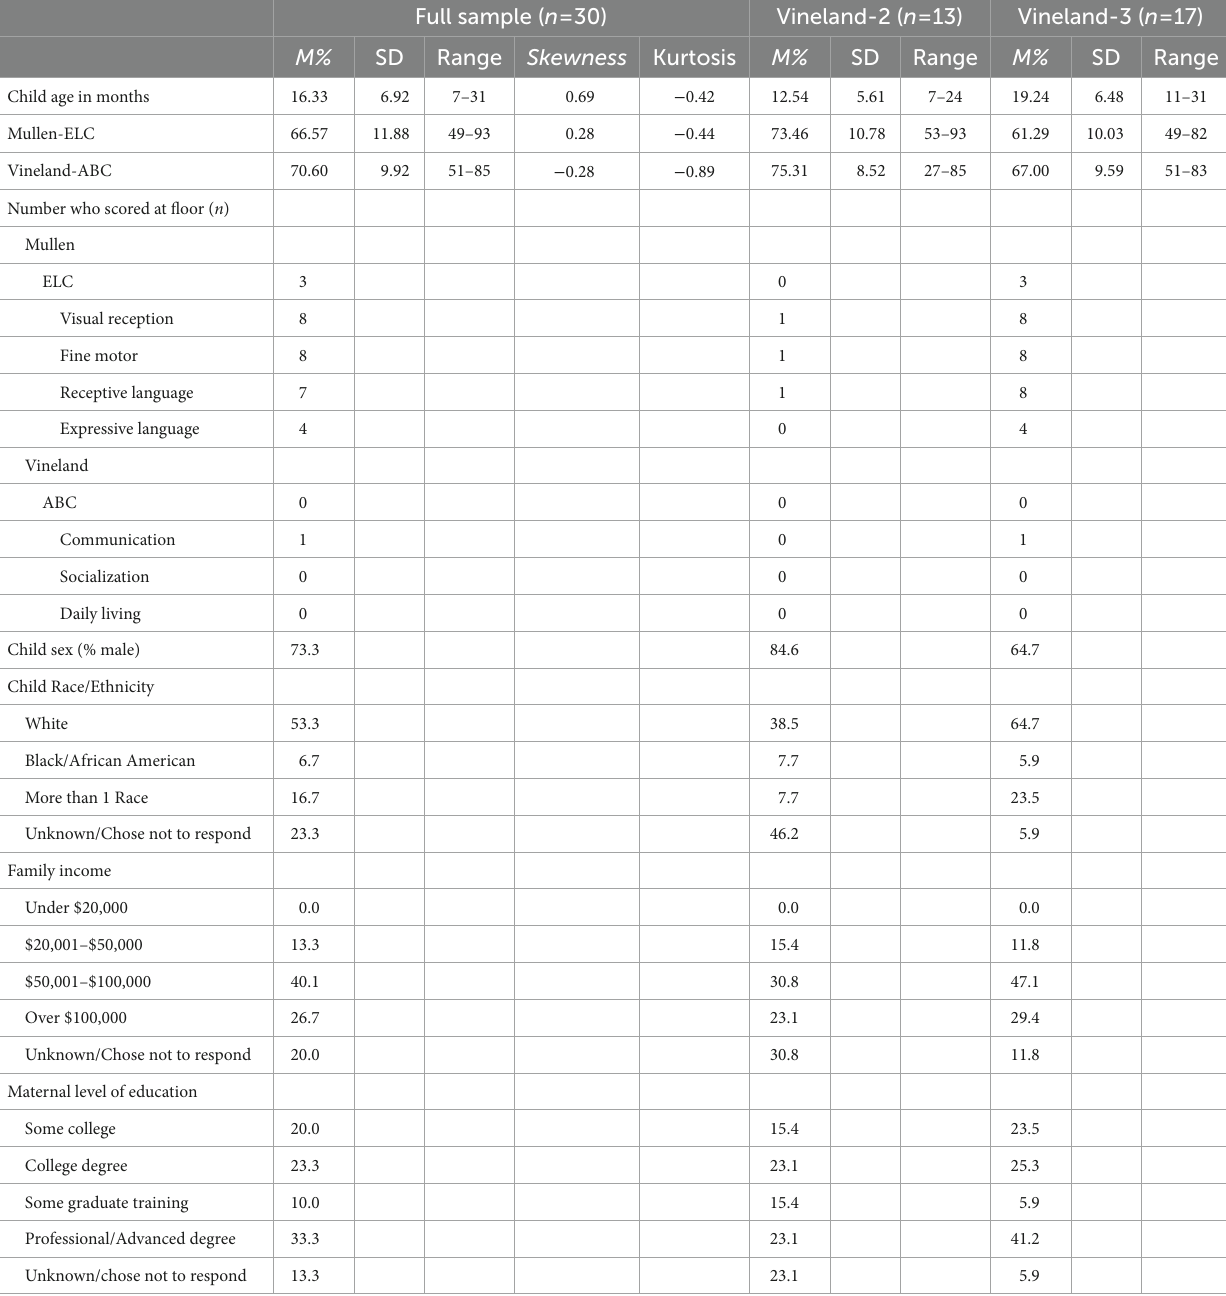
TABLE 1 Demographic